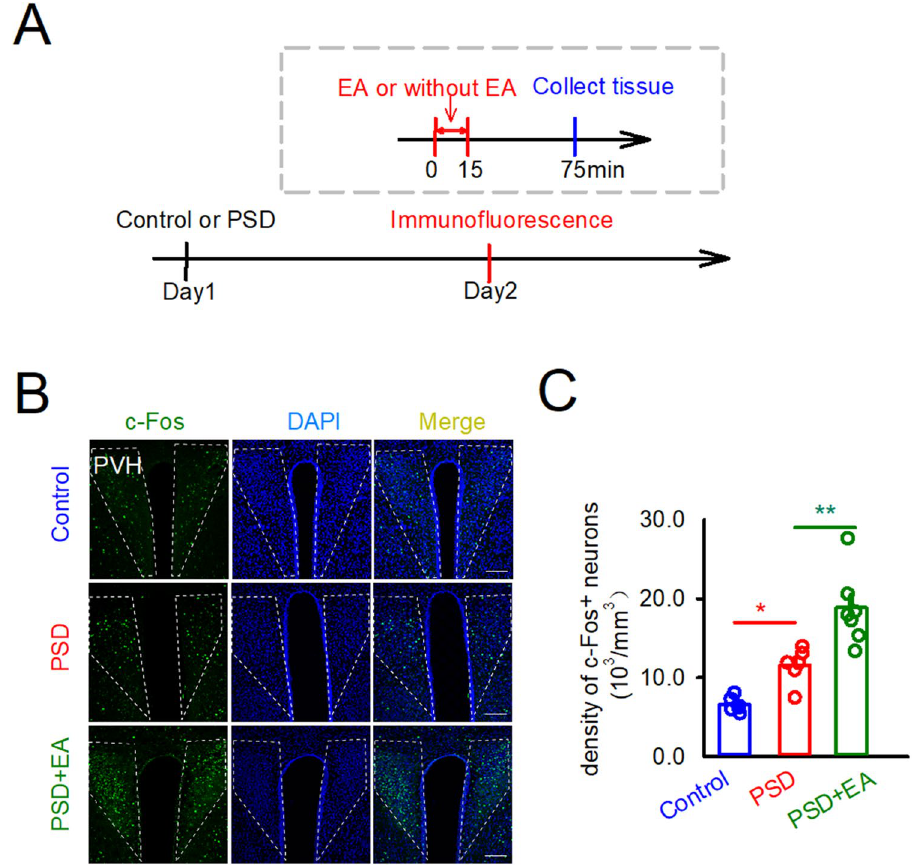
Figure 3. The function of PVH in stroke model. ( A ) Schematics of experimental design. ( B ) Representative images of the c-Fos neurons in PVH in the control group (top), model group (middle), model with EA at CV23 group (bottom). Data are shown as mean ± SEM (control and PSD: N = 6 slices, PSD + EA: N = 8 slices). ( C ) The statistical analysis of the density of c-Fos neurons in every group. 10 3 /mm 3 . One-way ANOVA with Tukey’s multiple comparisons test, * p < 0.05, ** p < 0.01. Scale bars: 100